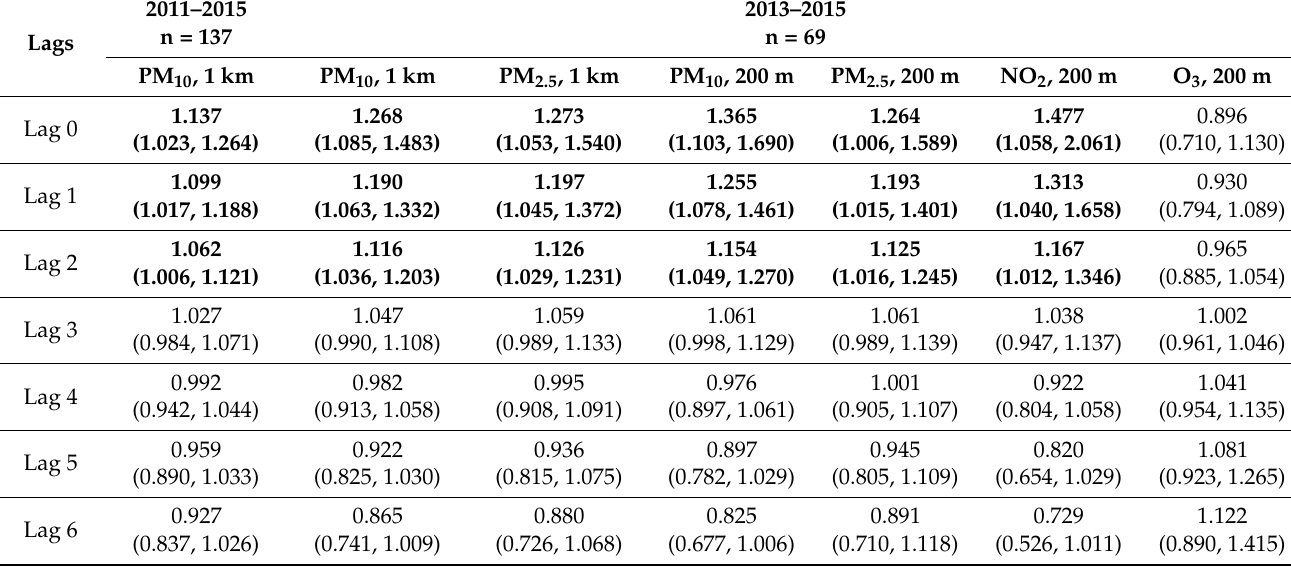
Table 4. Acute effects of estimated pollution levels on the risk of cardiovascular hospitalizations: odds ratios (10 µ g/m 3 increase) and 95% confidence intervals through the conditional logistic regression